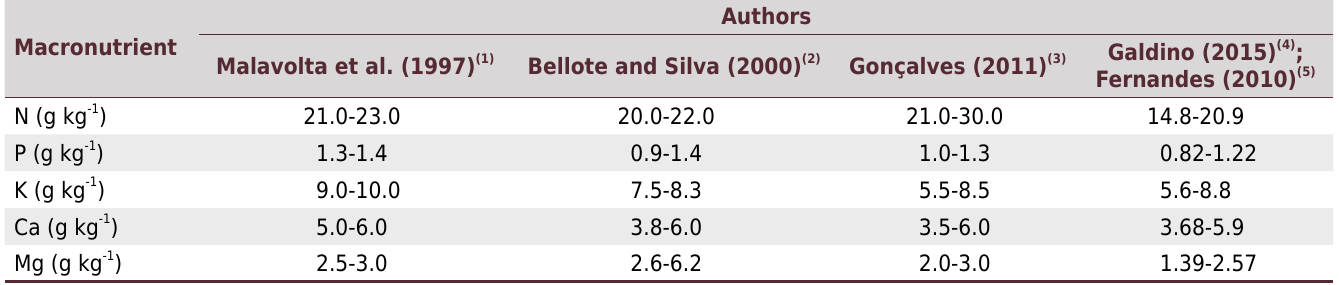
Mg in Eucalyptus plantations in Brazil obtained by the boundary